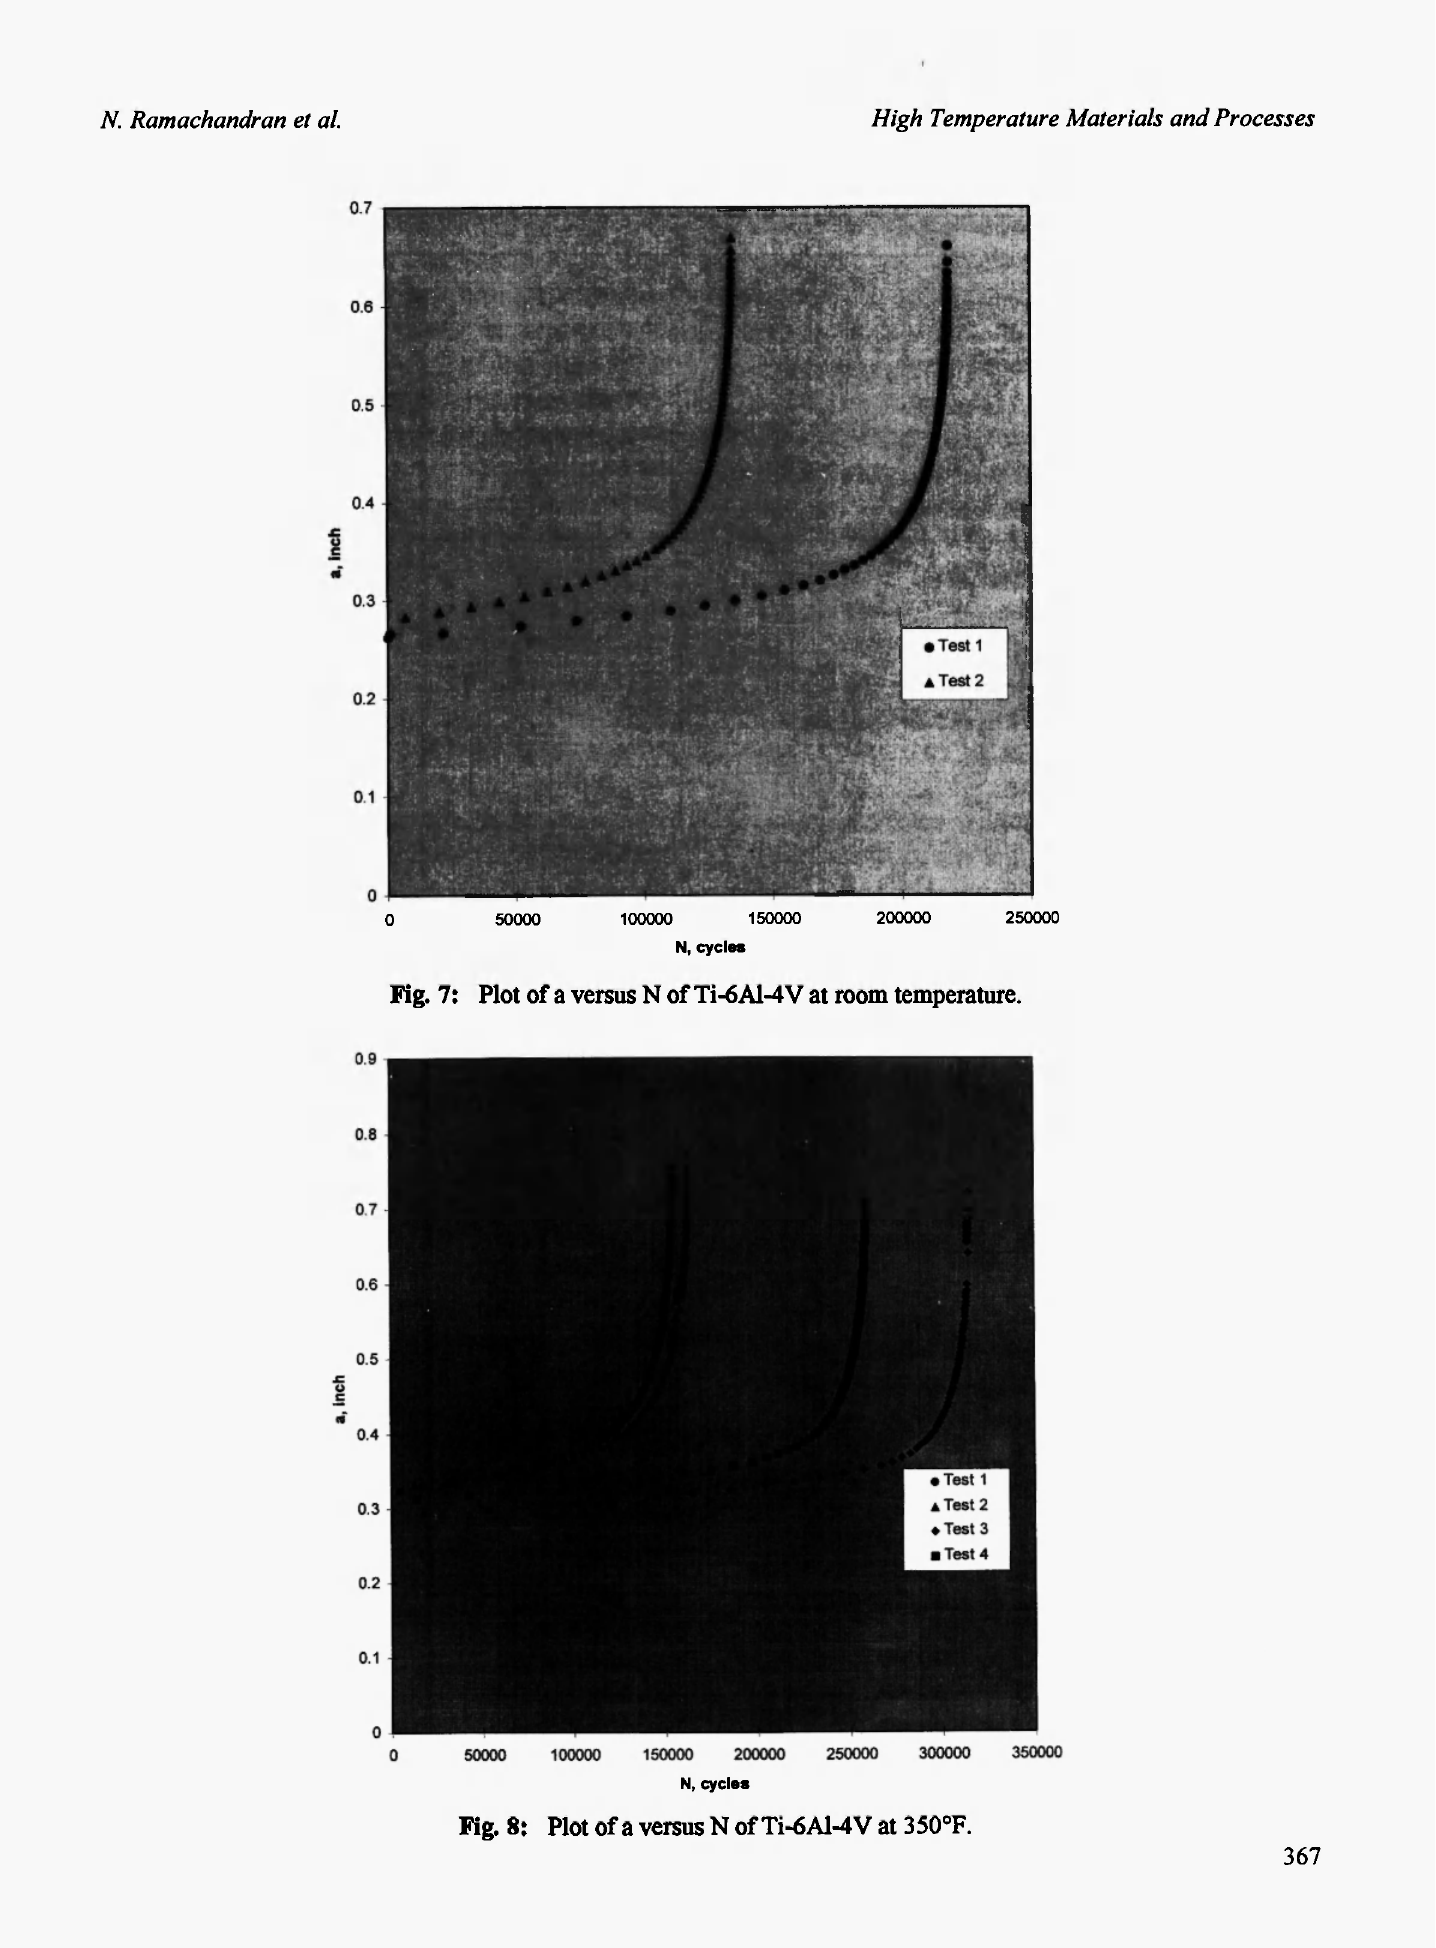
Fig. 8: Plot of a versus Ν of Ti-6A1-4V at